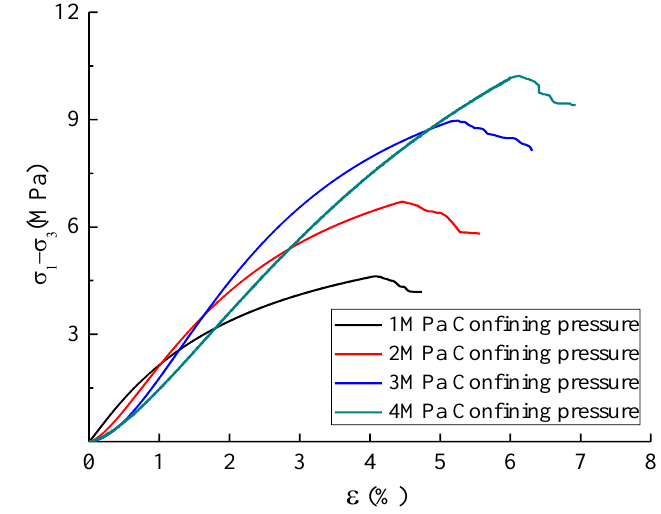
ff erent principal stresses at di ff erent confining pressures. Figure 9. Curves of different principal stresses at different confining pressures. Figure 9. Curves of di